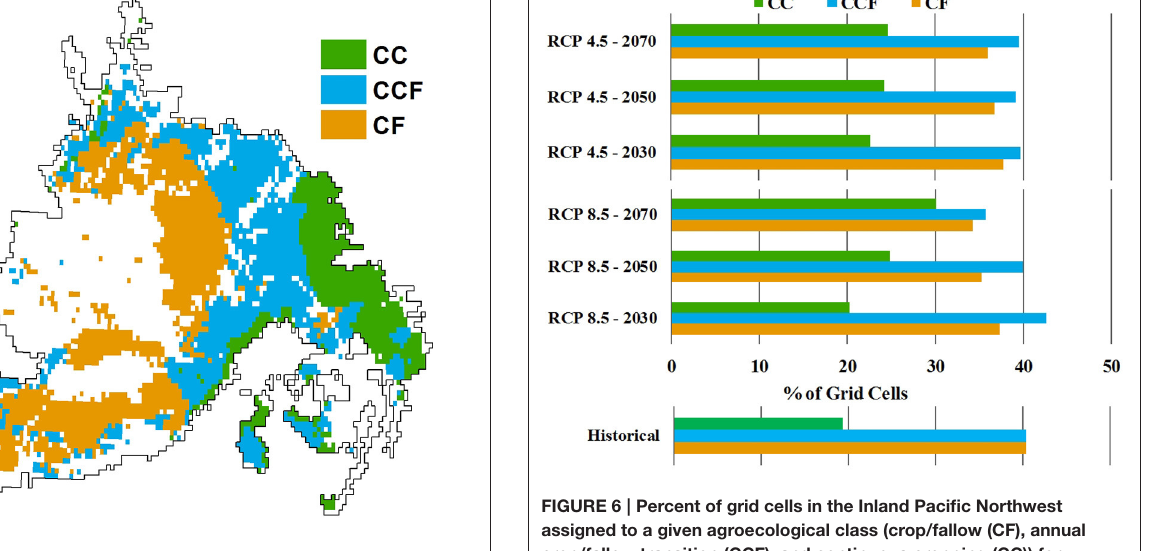
FIGURE 4 | Baseline agroecological classes in the dryland region of the Inland Pacific Northwest (crop/fallow (CF), annual crop/fallow transition (CCF) and continuous cropping (CC)), based on 32-year simulations (1979–2010).